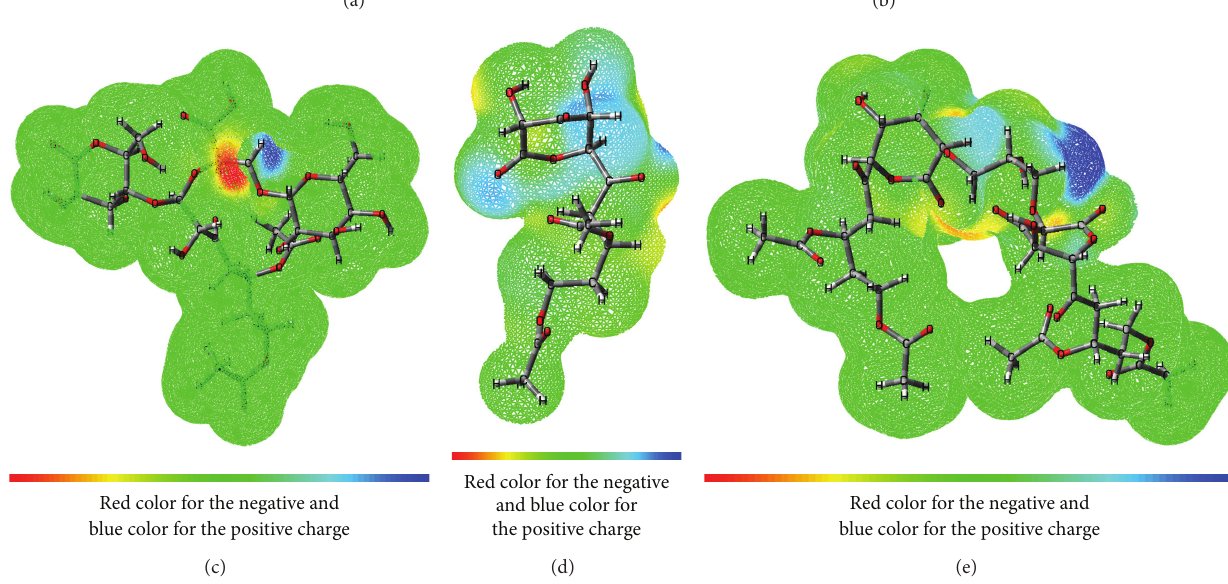
Figure3:Electrostaticpotential(EP)oftheoxidizedmodifiedstarchmoleculesattheB3LYP/6-31Gleveloftheory.(a)and(b)aretheoxidized starch molecules, respectively; (c) and (d) are the oxidized grafted starch molecules, respectively; and (e) is the oxidized grafted cross-linked starch